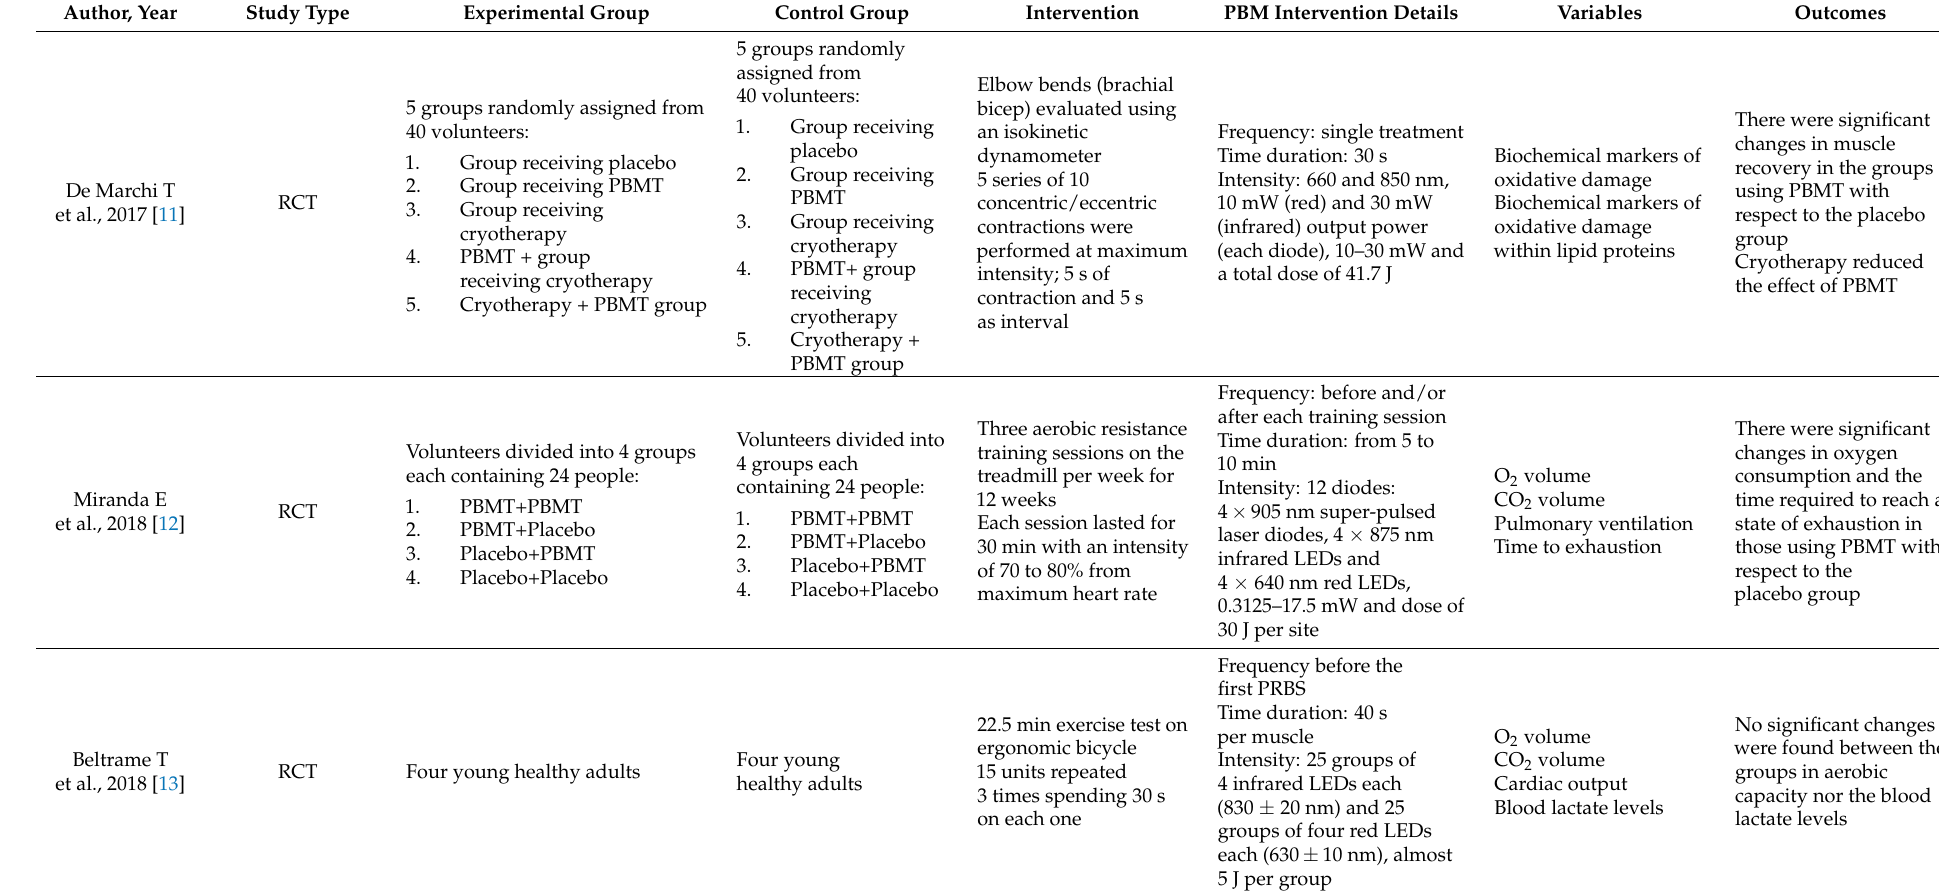
Table 4. Breakdown of the main characteristics of studies in the